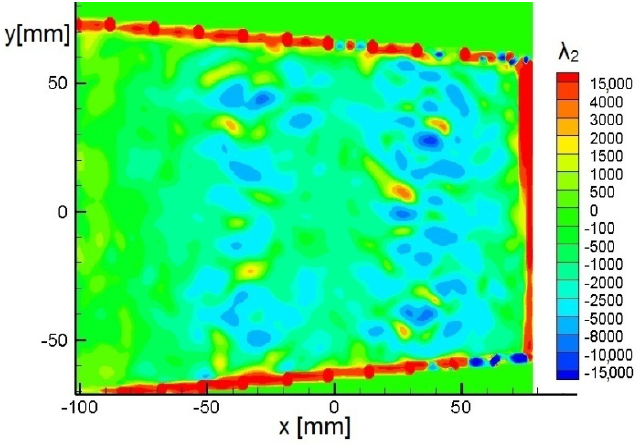
Figure 7. Distribution of λ 2 in the measuring cross-section.